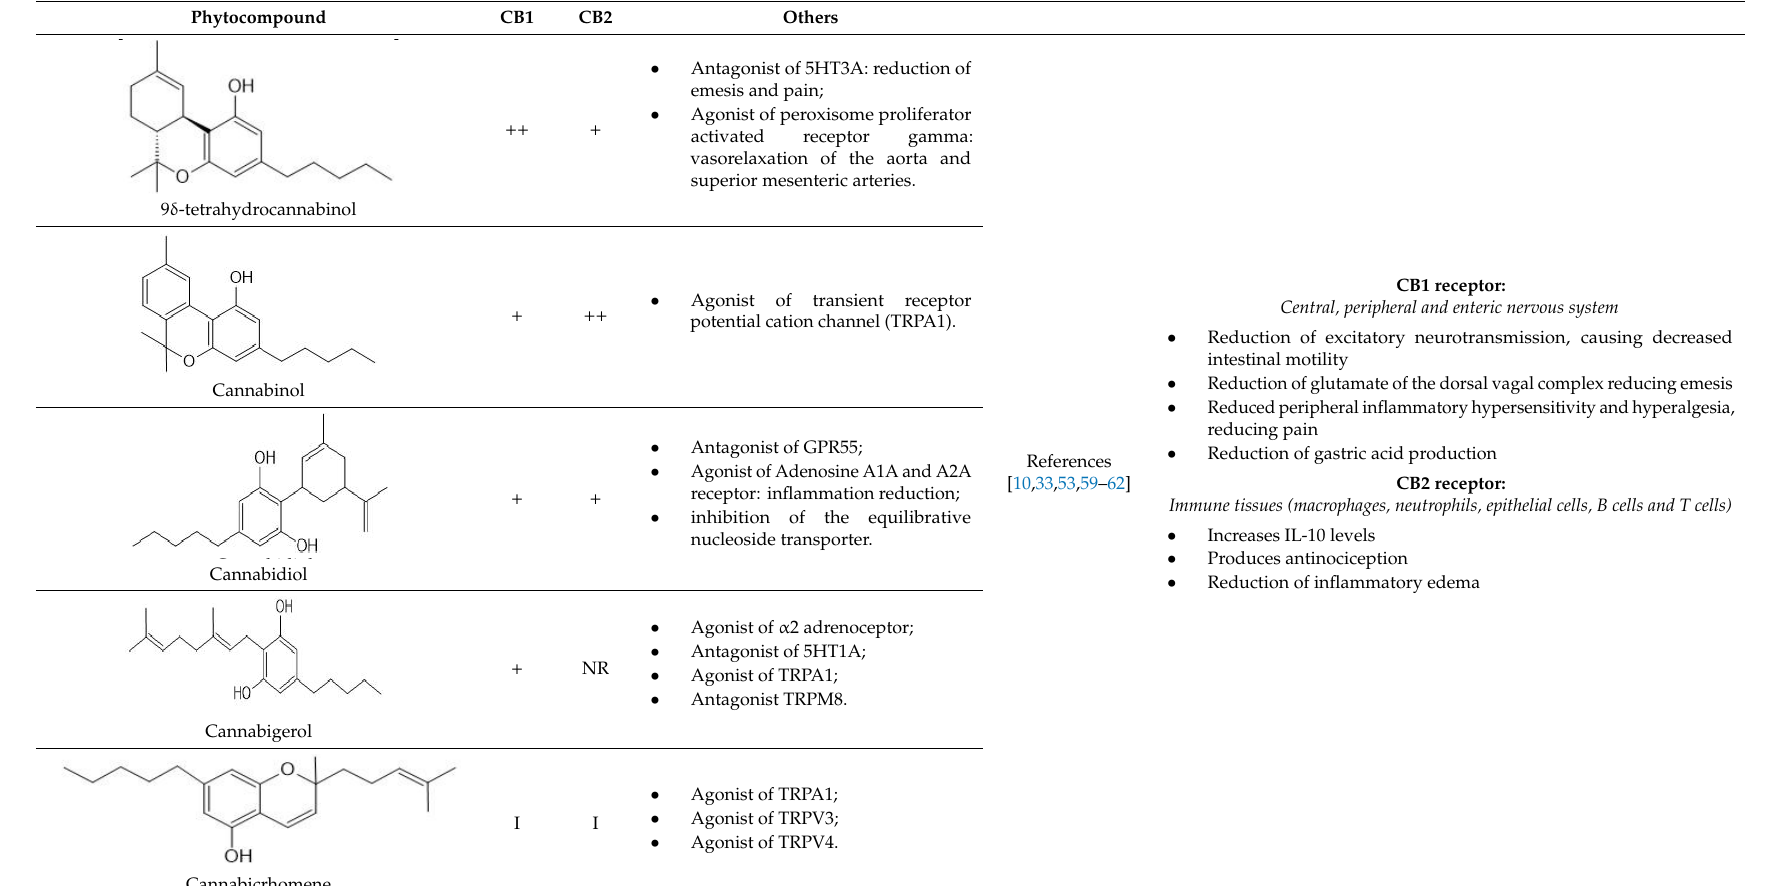
Table 2. Some relevant phytocompounds found in Cannabis sativa and possible actions.